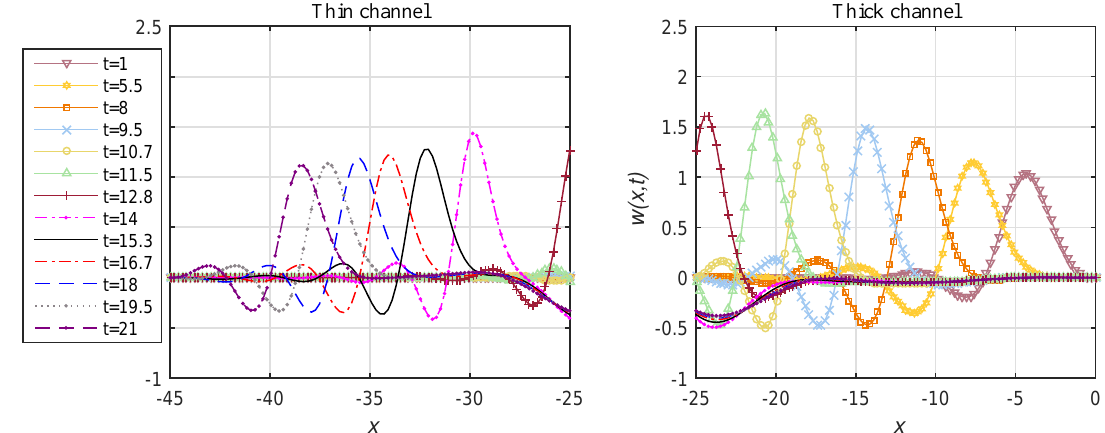
Figure 8. The experiment with α 2 = 4.5 α 1 ( a = 1/8, b = 4.5/8, c = 1); the time ranges from t = 1 to 21.